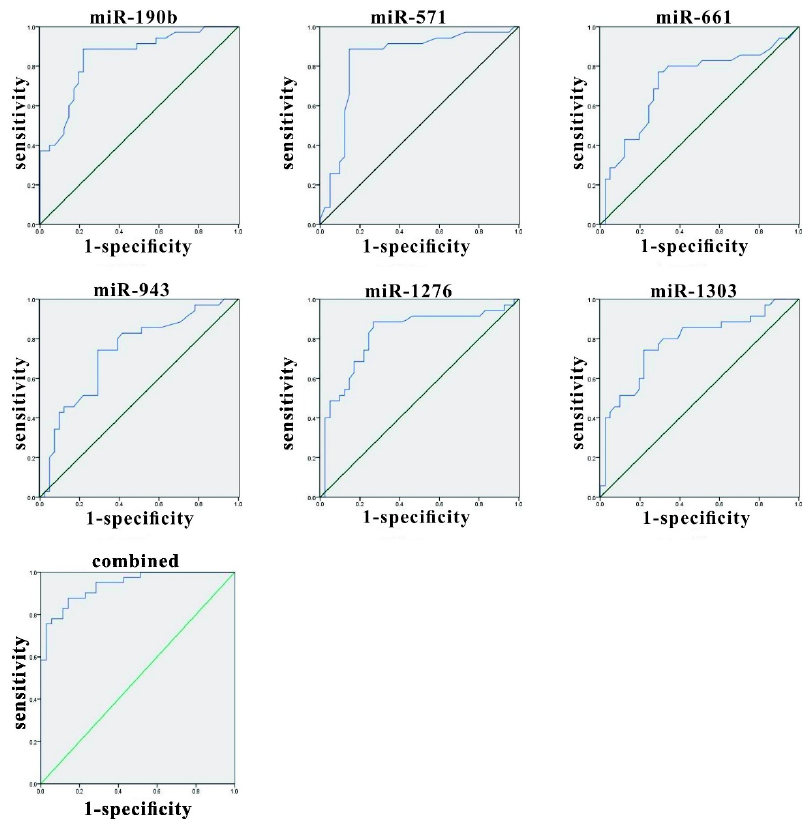
Figure 2. Receiver operating characteristic (ROC) curves of differentially expressed miRNAs between HZ patients and healthy controls. ROC curves of miR ‐ 190b, miR ‐ 571, miR ‐ 1276, miR ‐ 1303, miR ‐ 943, and miR ‐ 661 showed a moderate distinguishing efficiency. The combination of the six miRNAs showed a slightly higher area under the ROC curve (AUC) value of 0.939. Table 3. AUC and the asymptotic 95% CIs of the individual miRNA in ROC curves. Asymptotic 95% CI Asymptotic miRNA AUC SE Lower Upper Significance Bound Bound